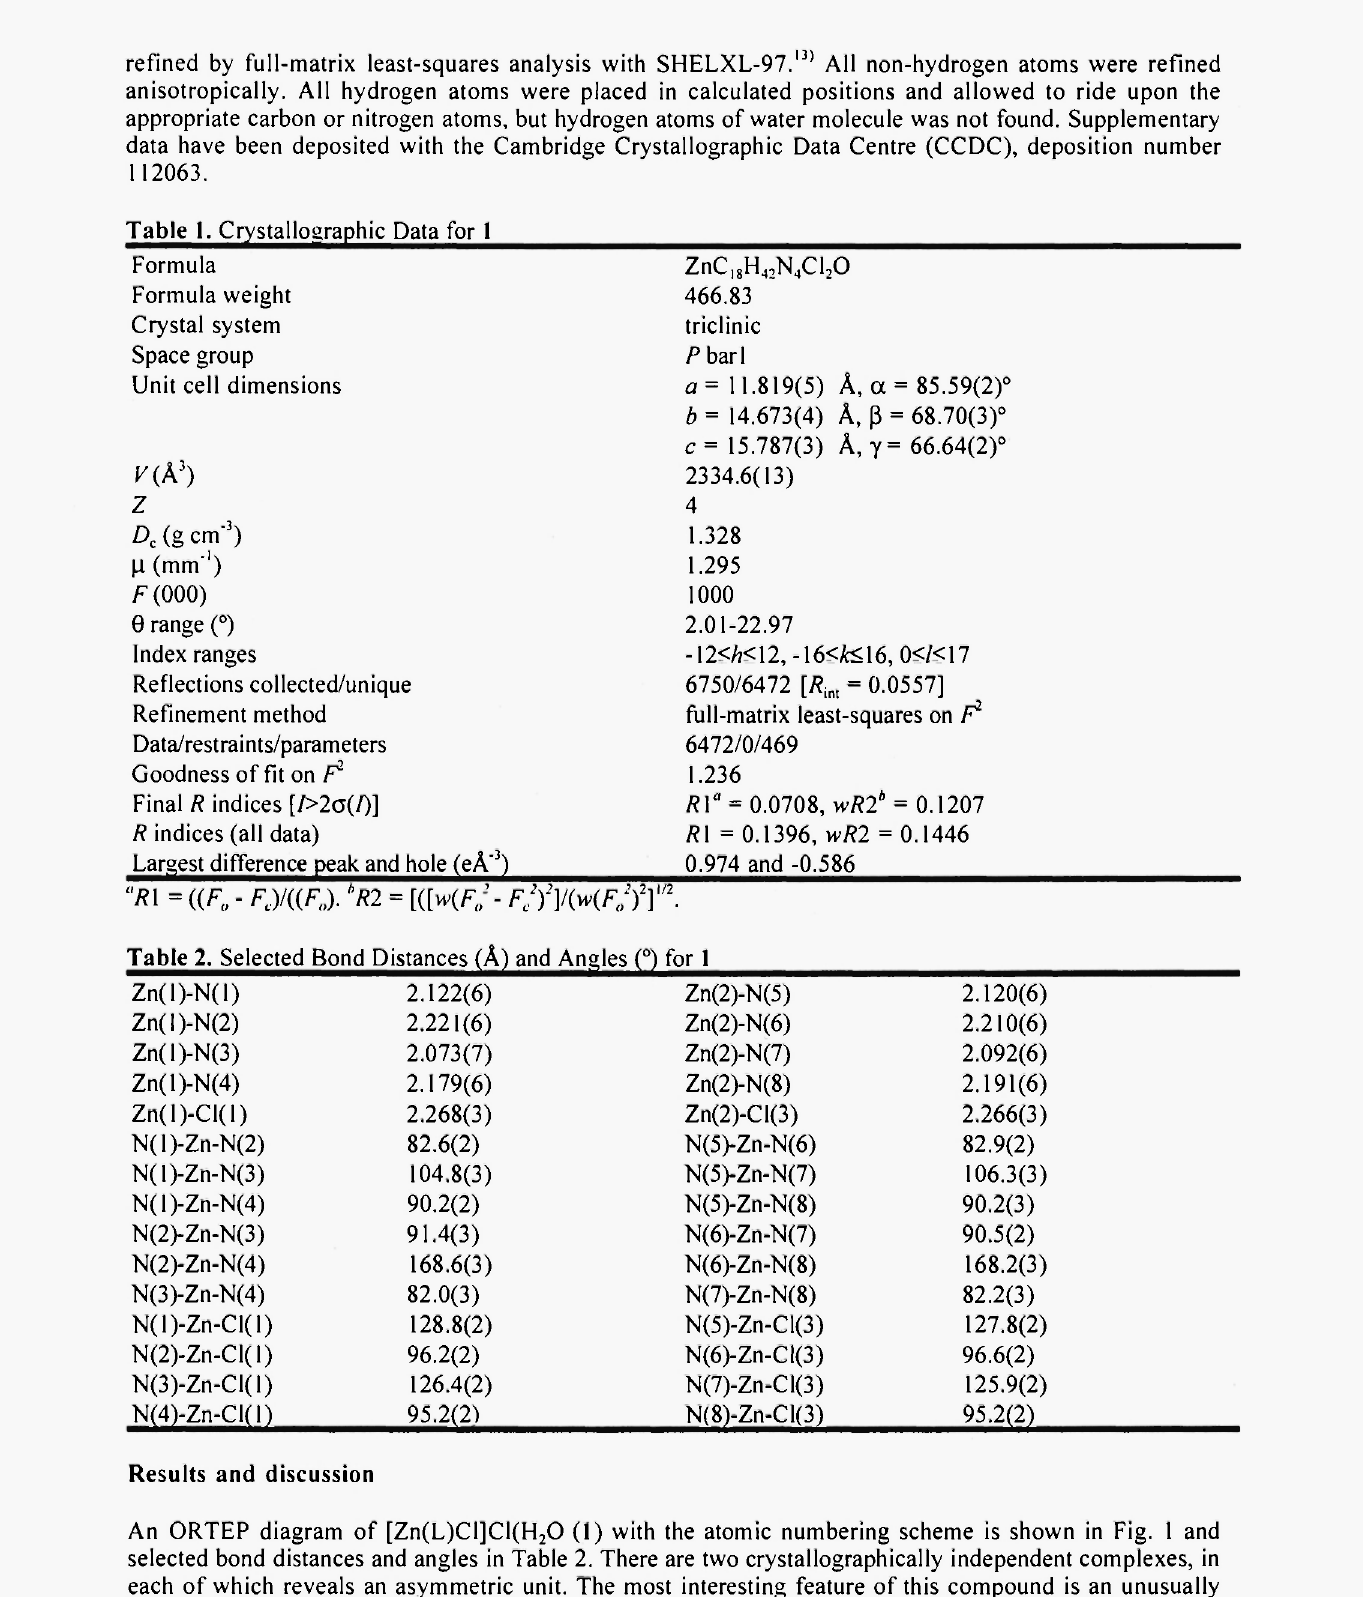
Table 1. Crystallographic Data for 1